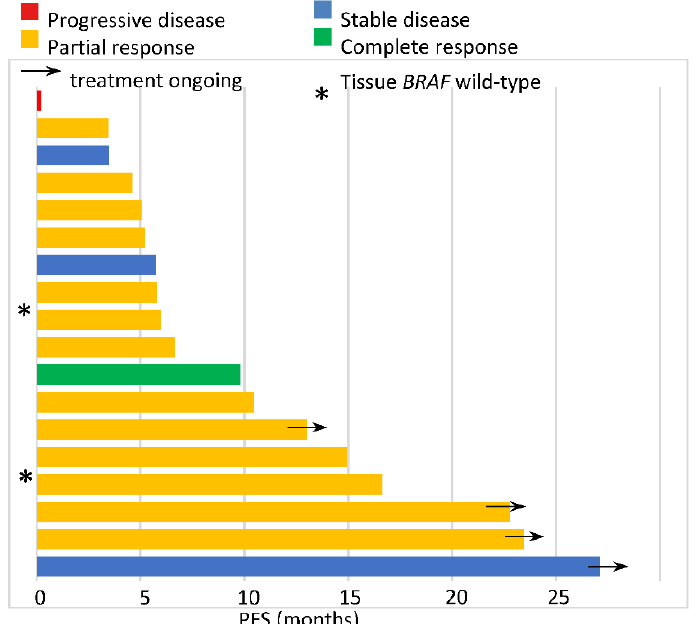
Figure 2. Progression-free survival with BRAF/MEK inhibitors administered based on the ctDNA